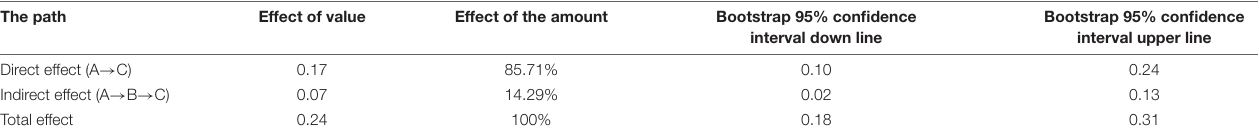
TABLE 4 | Bootstrap analysis of significance test of mediation effect ( n = 308).